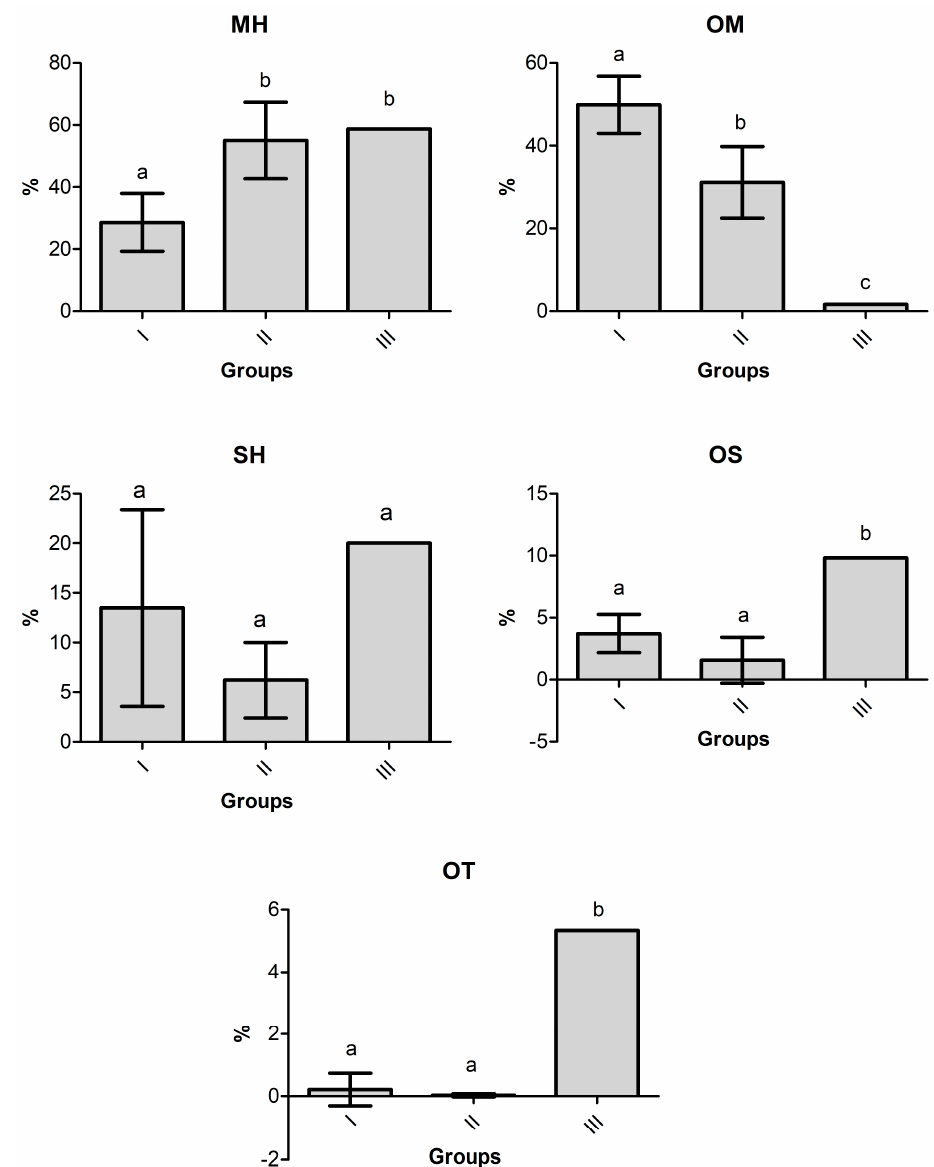
Figure 4. Compound classes of the H. crenata chemotypes. Mean ± standard deviation. Values with the same letters (a or b) in the bars do not differ statistically in the Tukey test ( p > 0.05). MH - mon- oterpene hydrocarbons, OM - oxygenated monoterpenes, SH—sesquiterpene hydrocarbons, OS— oxygenated sesquiterpenes, OT - other compounds.